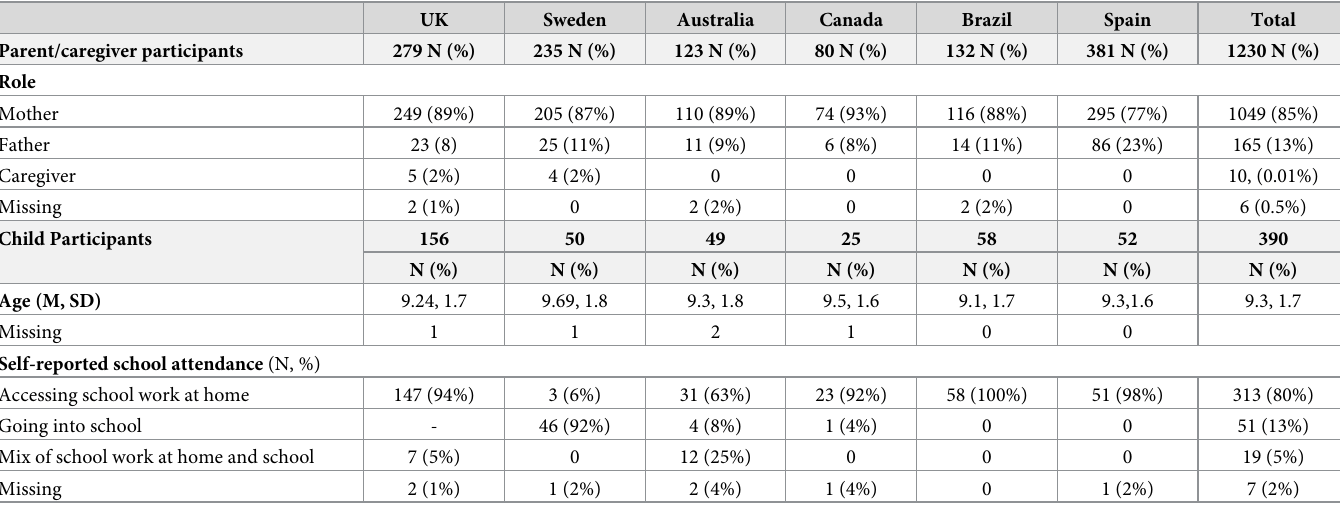
Table 3. Basic demographic information of the participants.